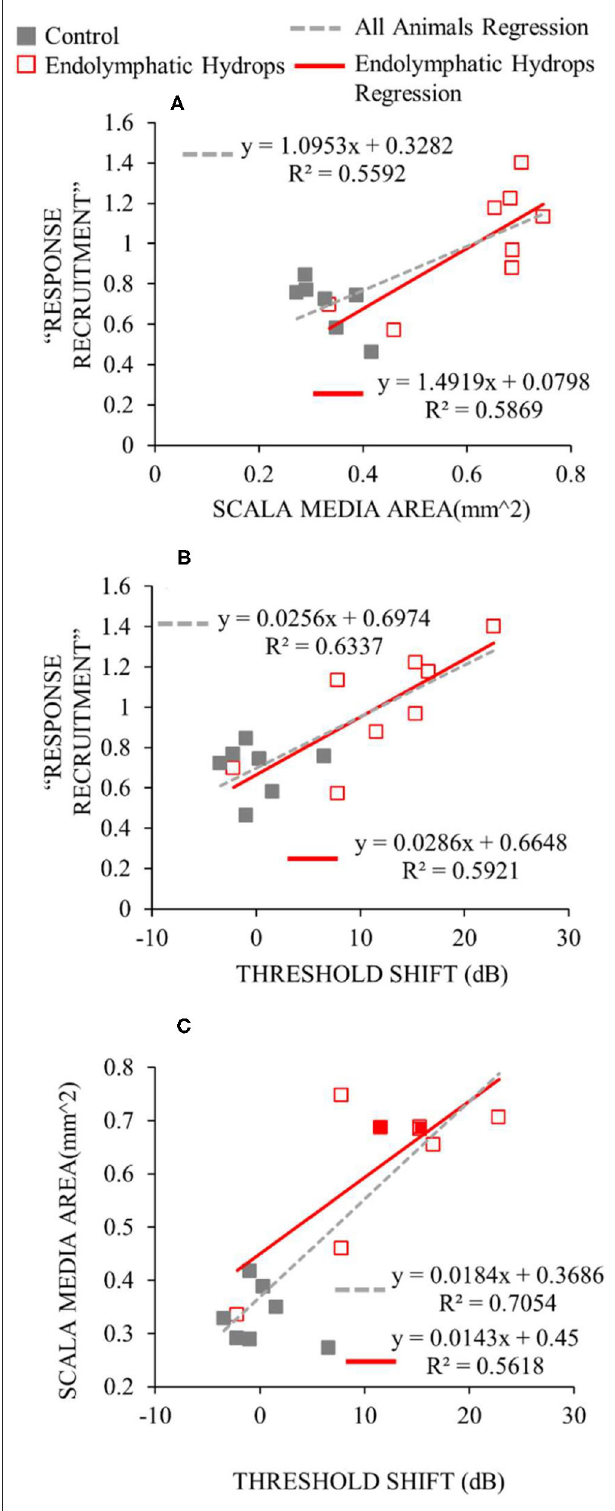
FIGURE 7 | Functional and histological assessments compared. For the y-axis of (A,B) , the median slopes of the response growths were averaged across low frequencies ( ≤ 1kHz). For the x-axis of (A) , the scala media area was